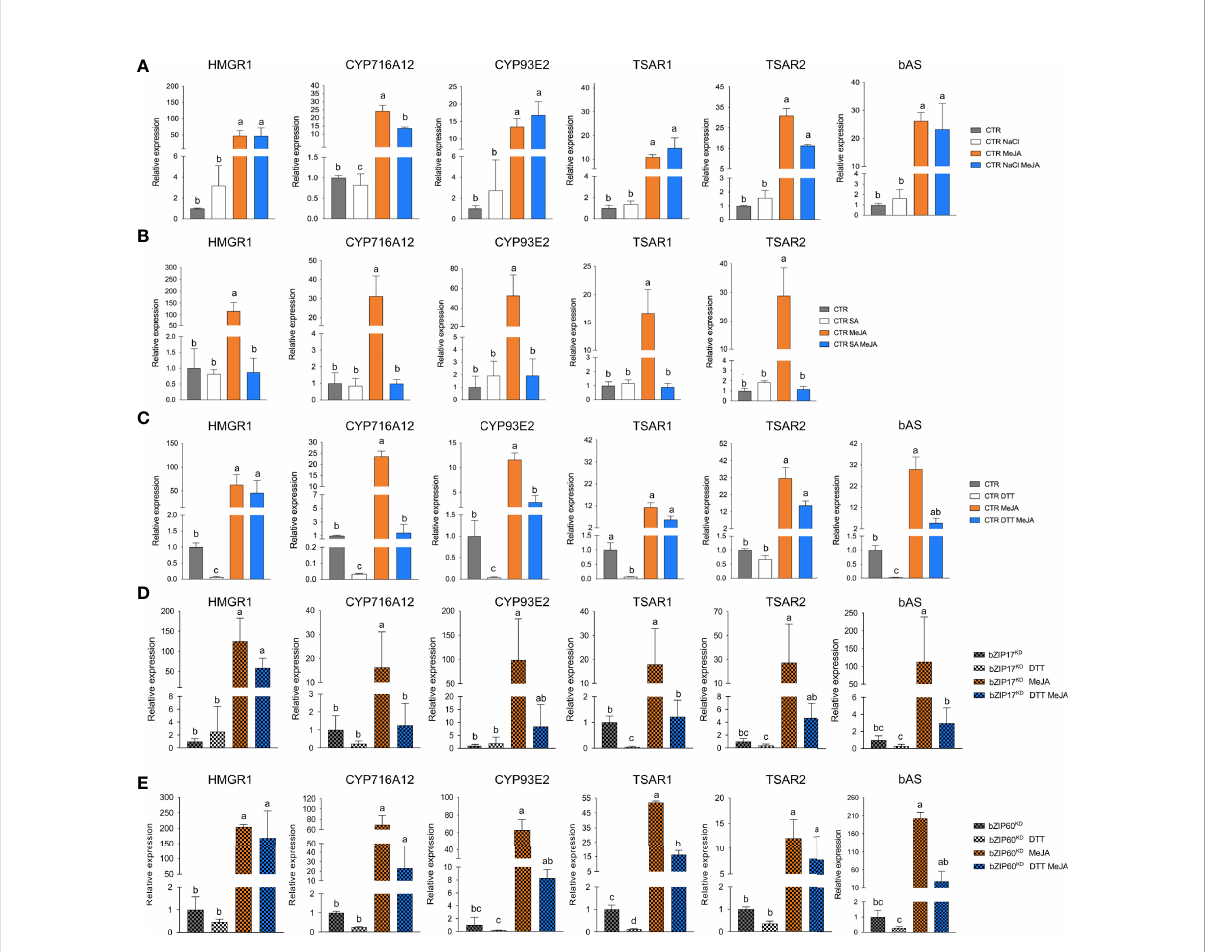
FIGURE 6 Effects of ER stress on the expression of TS pathway genes in M. truncatula hairy roots. (A-E) qRT-PCR analysis of TS pathway genes in control (CTR) (A-C) , bZIP17 KD (D) and bZIP60 KD (E) hairy root lines. Hairy roots were treated with 300 mM NaCl (A) , 0.5 mM SA (B) or 2 mM DTT (C-E) for 4 h prior to the 4-h MeJA treatment (5 µM for (A, C-E) and 100 µM for (B) ). Expression ratios were plotted relative to the normalized mock- treated line. The error bars designate SE (n = 3 for (A-D) and n = 2 for (E) , corresponding to the independent transformed CTR, bZIP17 KD and bZIP60 KD lines generated). Different letters sample indicate statistically signi fi cant differences at P < 0.05, as determined by ANOVA, post hoc Tukey